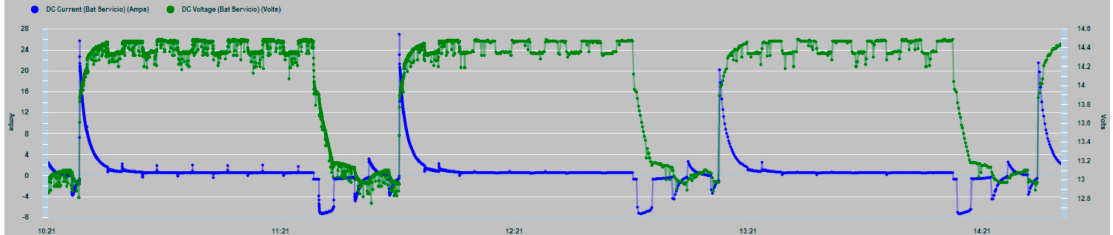
Figure 19. House battery bank charge cycling zoom.